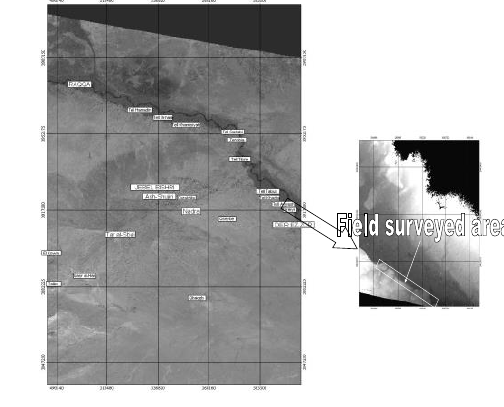
Figure 2. Mapping some major sites using the panchromatic channel of Landsat-7 ETM and MapSheets Express software as well as locating a survey area at the river edge with ASTER- DEM data. Mapping by M. Lönnqvist (present Silver) 2006.